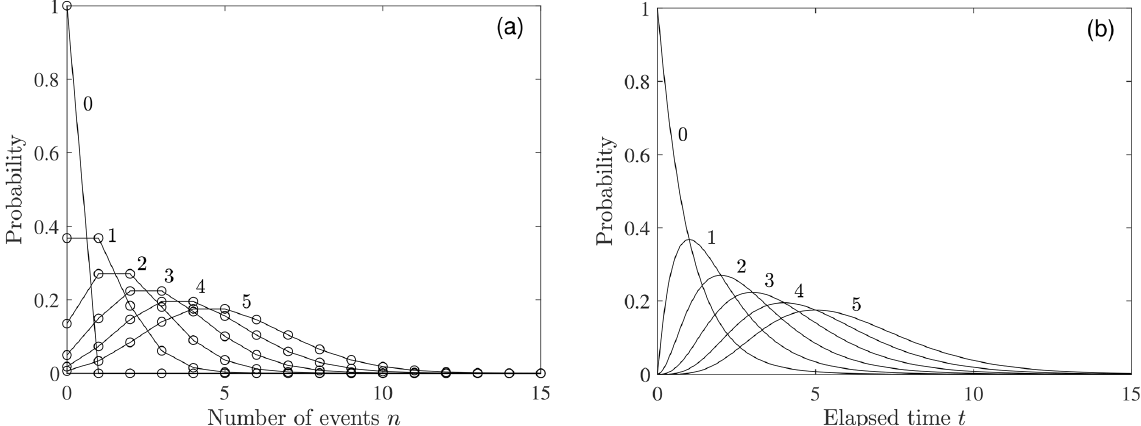
Figure D1. Plot of time evolution of (a) Poisson ensemble distribution f n ( n,t ) of the proportion N ( n ) /N e of systems with n events at time t = 0, 1, 2, 3, 4 and 5, and (b) proportion N ( n ) /N e of systems with n = 0, 1, 2, 3, 4 and 5 events. Plots are based on η = 1. Lines connecting the probability values (circles) in (a) are to aid visualization of successive states of the discrete distribution and do not imply the presence of non-integer values of n